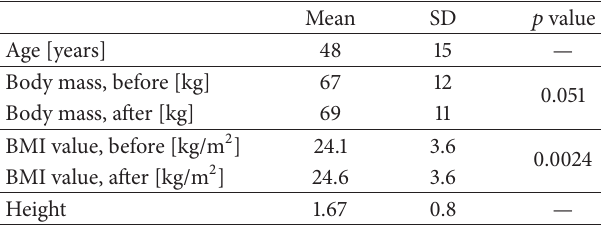
Table 1: Descriptive statistics for demographic characteristics of the tested sample ( 𝑛 = 33 ) ( 𝑝 value of Wilcoxon’s matched pairs test).